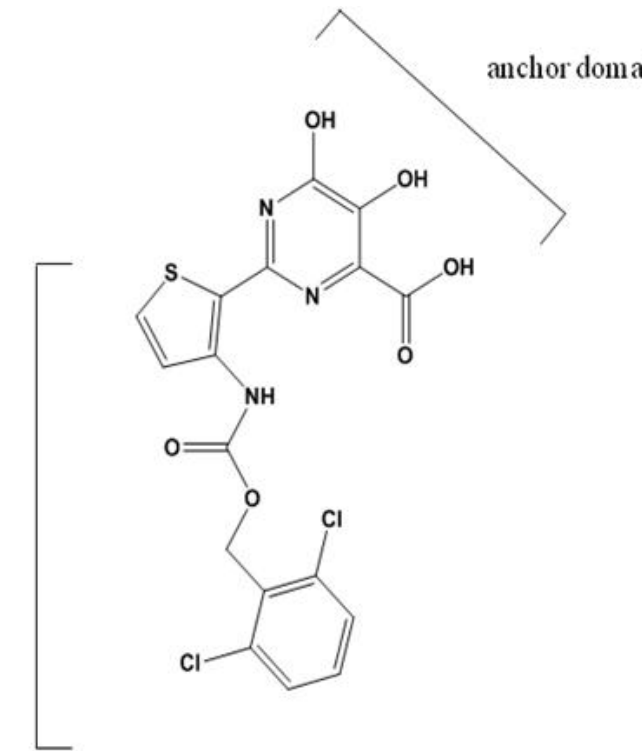
Figure 3. Structure of a PPi analogue. The inhibitor contains two distinct domains: the “anchor domain”, which is implicated in interactions with the two catalytic metal ions at the active site, and the “specificity domain”, which provides additional contacts at distant regions of the